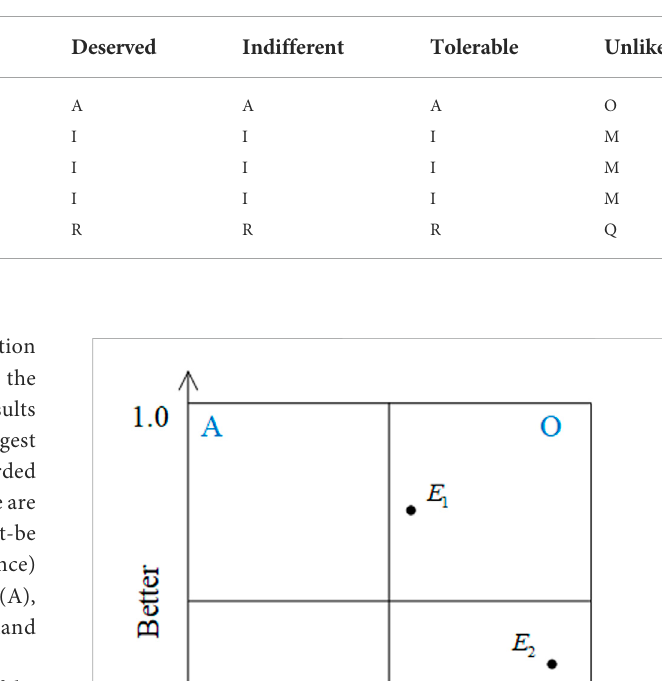
TABLE 2 Kano categories concerning demand attributes.